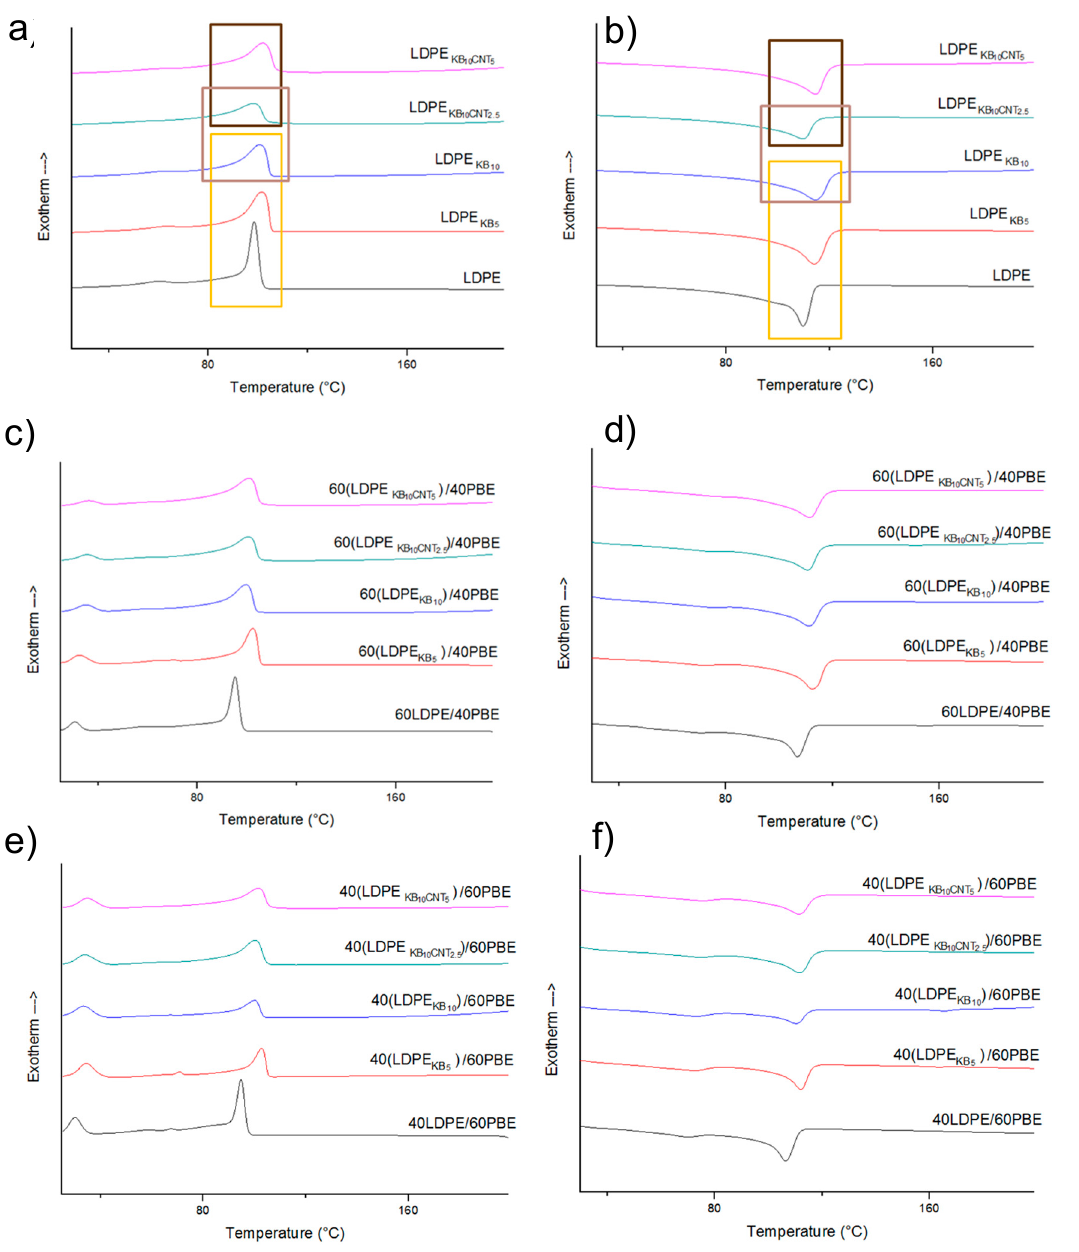
Figure 11. Crystallization ( a , c , e ) and melting ( b , d , f ) curves of the conducting biphasic polymers using different ratios of PBE, KB and CNT fillers.